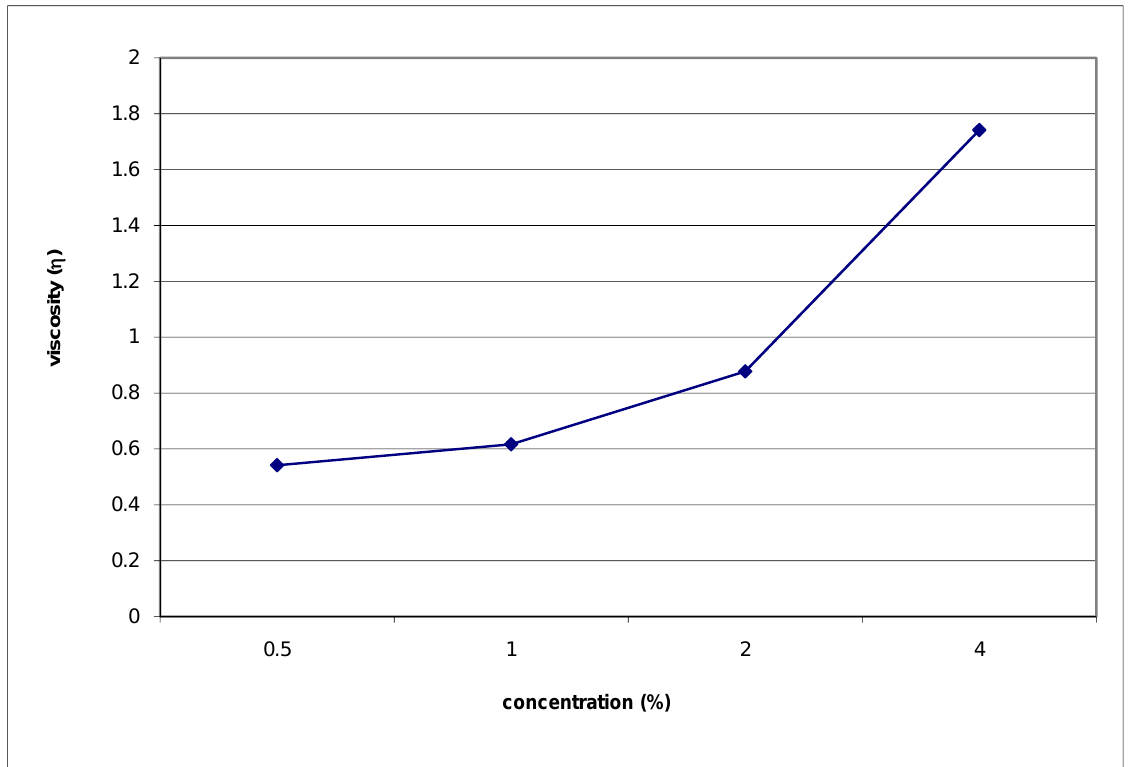
Figure 3 . Viscosity/concentration correlation of Sample A